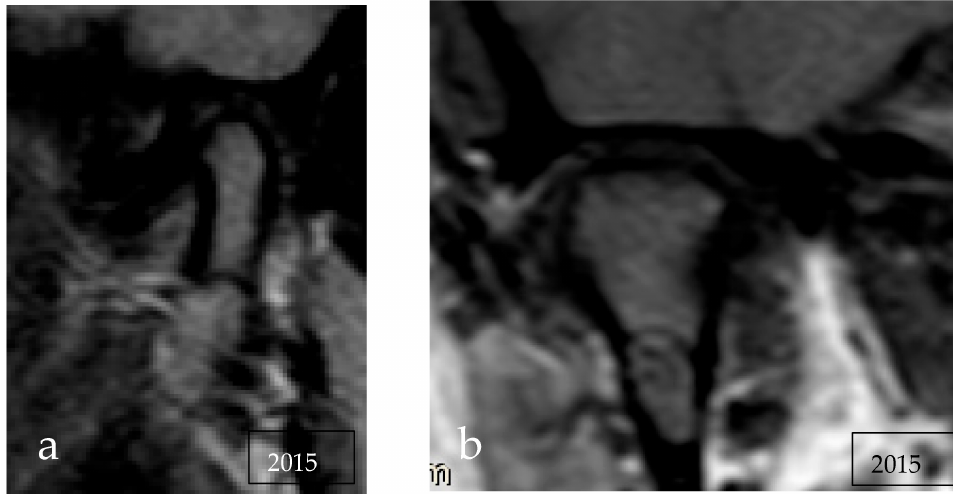
Figure 2. MRI scans showing an intraosseous lesion isointense to bone marrow and with a hy- pointense rib: ( a ) sagittal projection, ( b ) coronal projection.